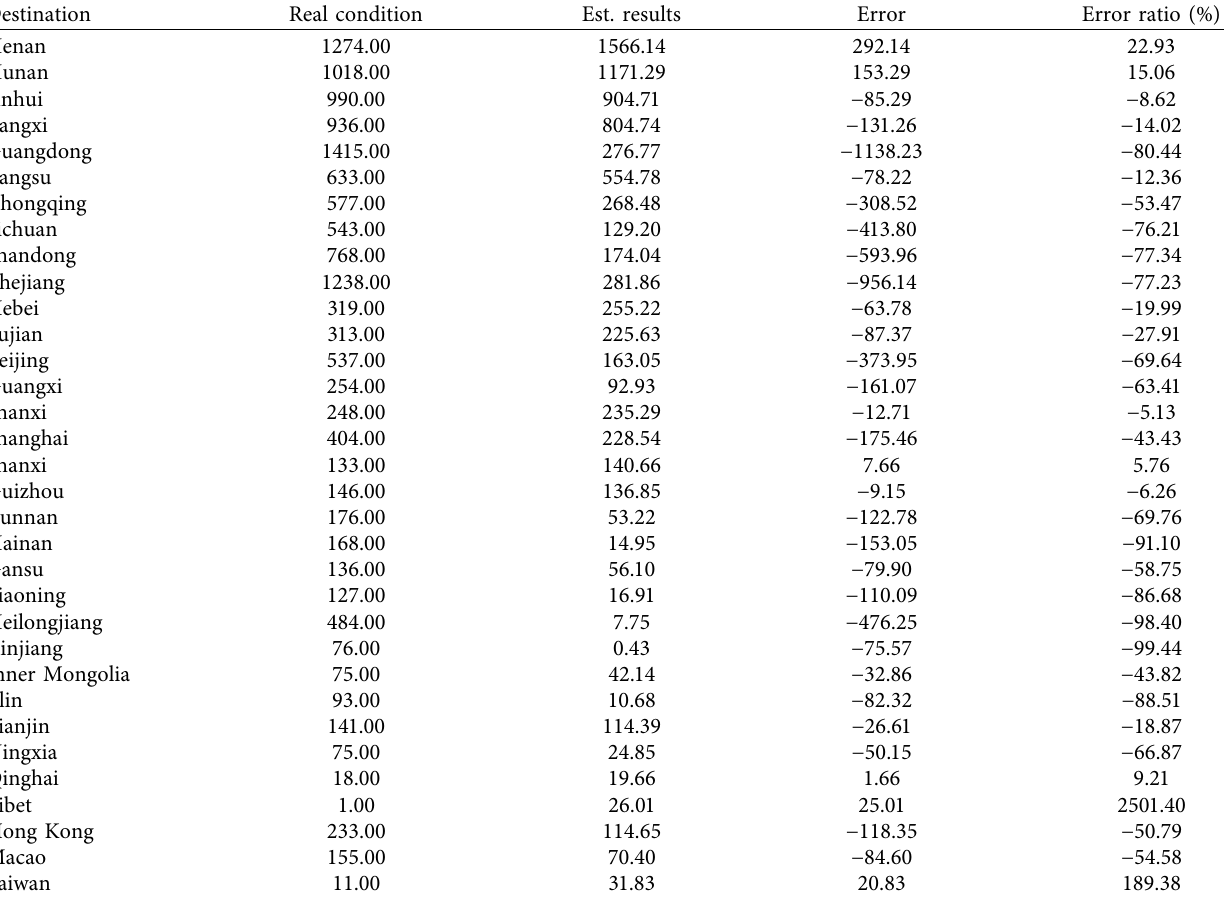
Table 9: Estimation of the number of incidence cases and the error of estimation for other province-level destination regions outside the province of Hubei.